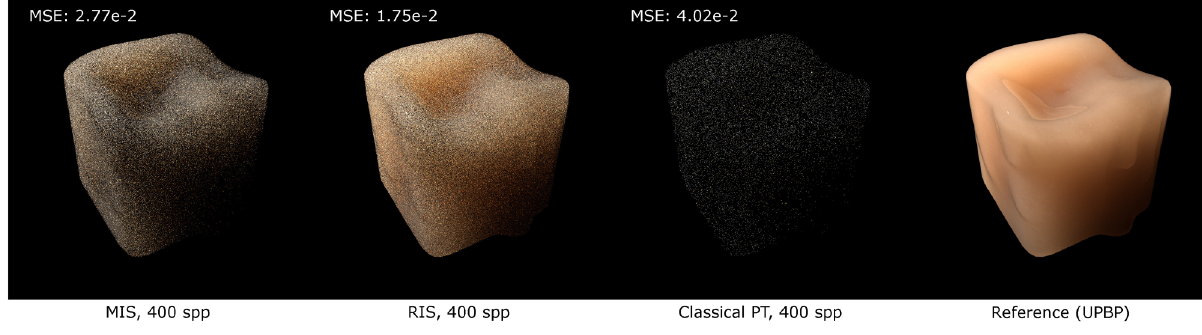
Fig. 3 Comparison of multiple importance sampling and our RIS with equal SPP (400) on the Candle